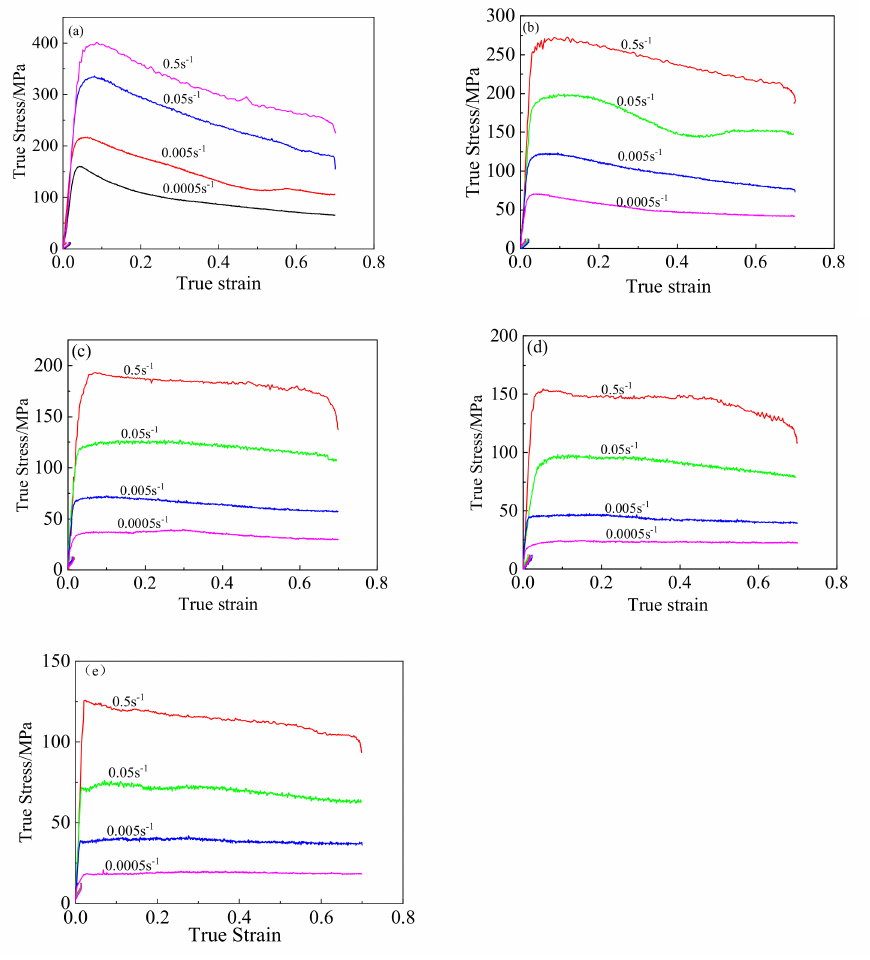
Figure 2. True stress–true strain curves of Ti-6Mo-5V-3Al-2Fe alloy at different temperatures: 700 ◦